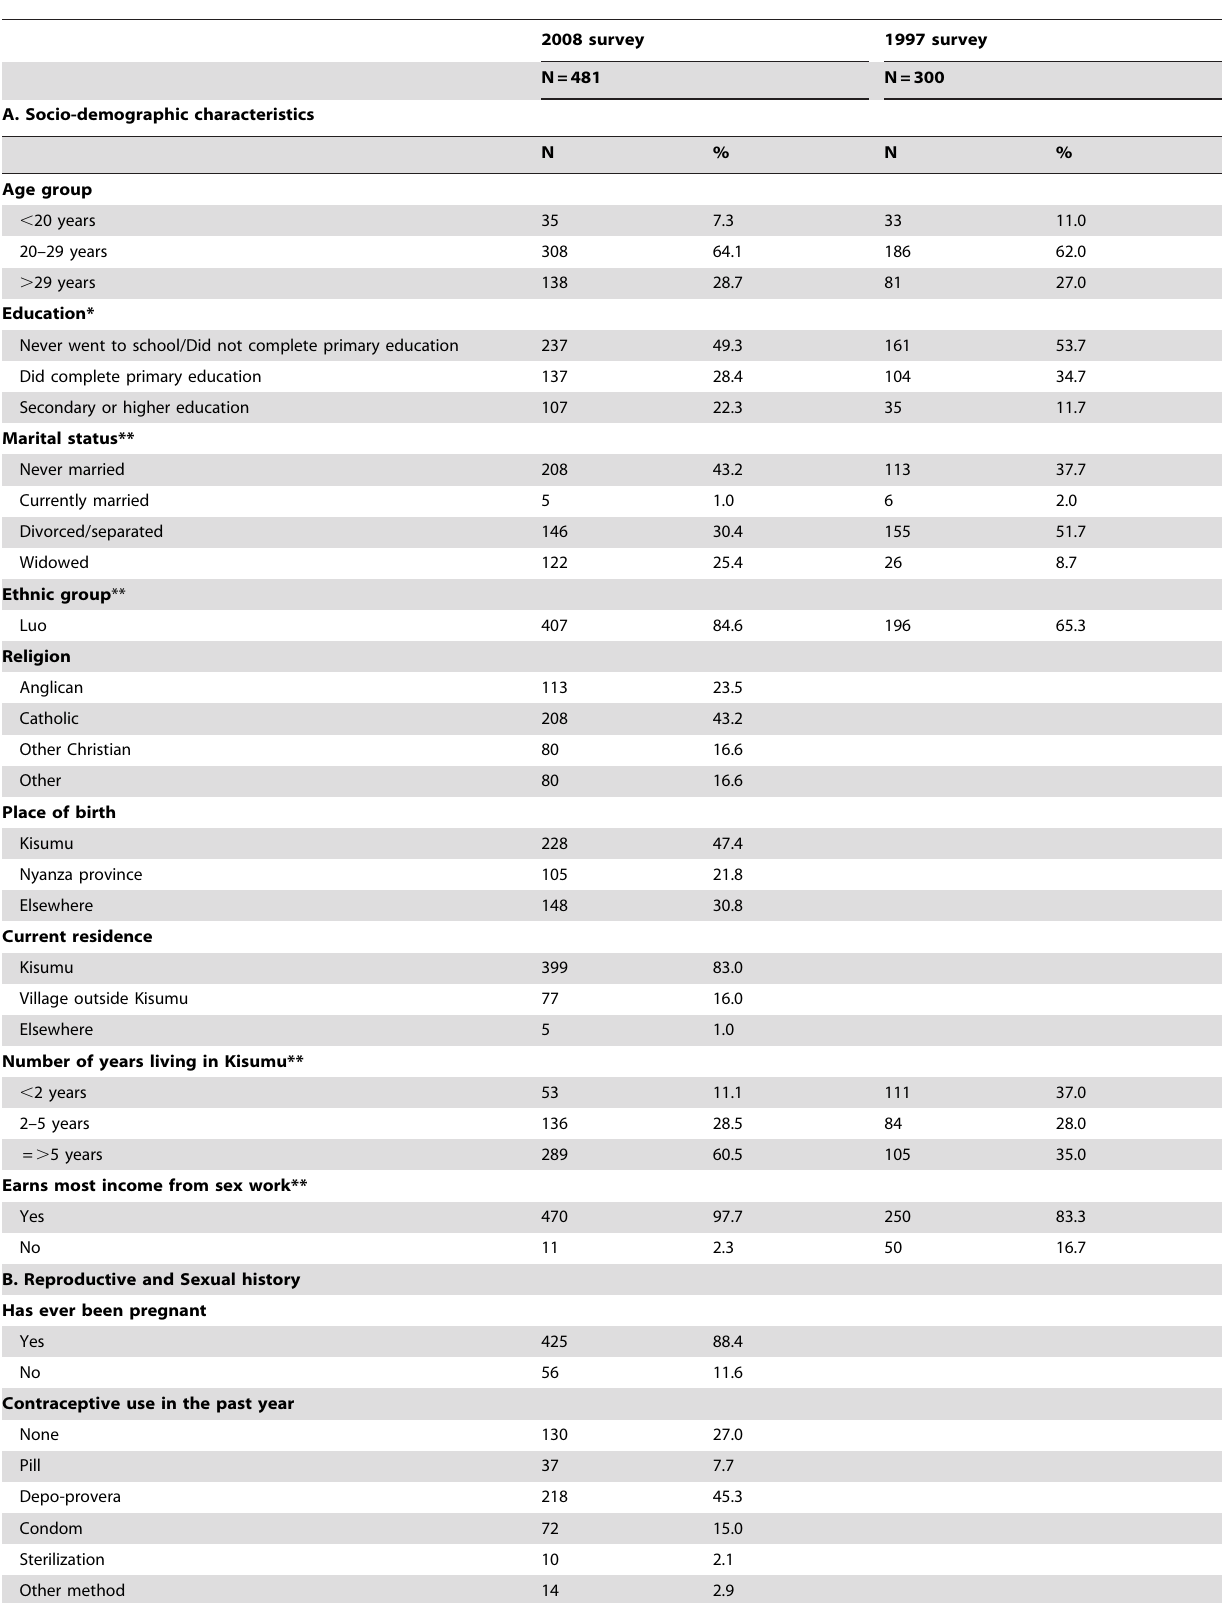
Table 1. Socio-demographic and behavioural characteristics of FSW study participants in 2008 and in